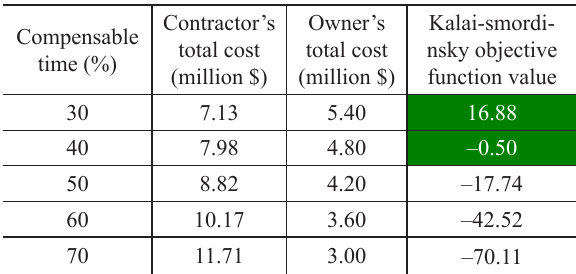
Table 2. Nash objective function value (with equal discount factor)